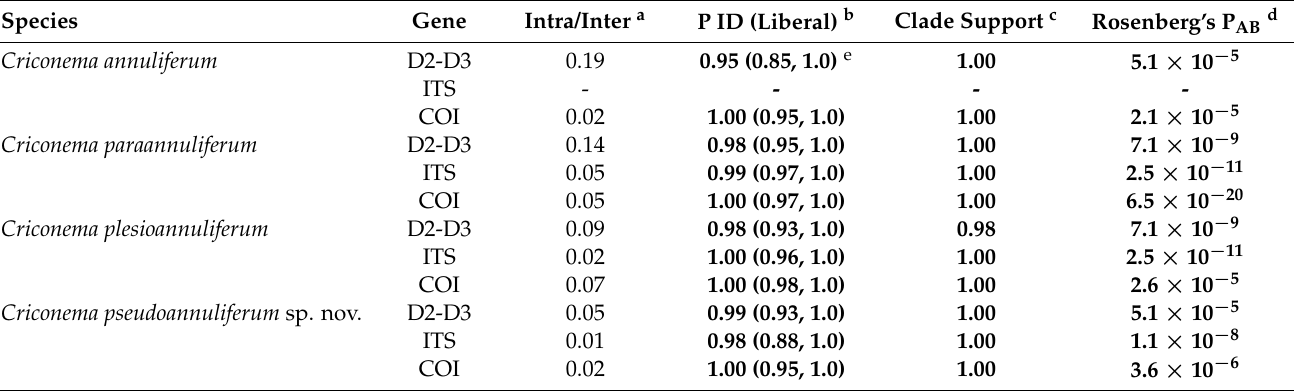
Table 2. Parameters evaluating Criconema annuliferum species complex delimitation based on two rRNA genes (D2-D3 expansion segments of the 28S rRNA, ITS) and one mtDNA barcoding locus, COI for four Criconema species of the